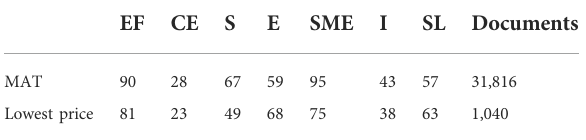
TABLE 7 SPP main category in % by award method ( n =